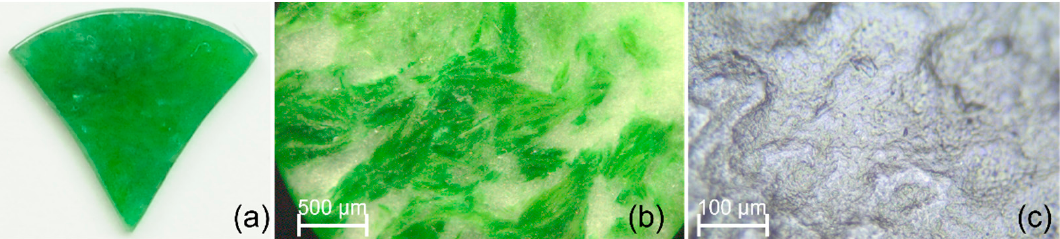
Figure 2. Jade aspect and texture details: ( a ) jadeite-jade, imperial green, Photo: M. Musa— Gemological Education and Certification Institute (GECI) reference stone collection: ( b ) jadeite- pumpellyite association (green veins) in albite white matrix (OM Image, 5× magnification, darkfield light), Photo: M. Musa—GECI reference stone collection; ( c ) nephrite-jade-polished cabochon surface, detail of its characteristic texture, where no iso-oriented acicular/columnar crystals are evident, but the grains are associated to elongated crystals, oriented in different directions (OM Image, 20× magnification, reflected light), Photo: M. Musa—Gulf Institute of Gemology (GIG).